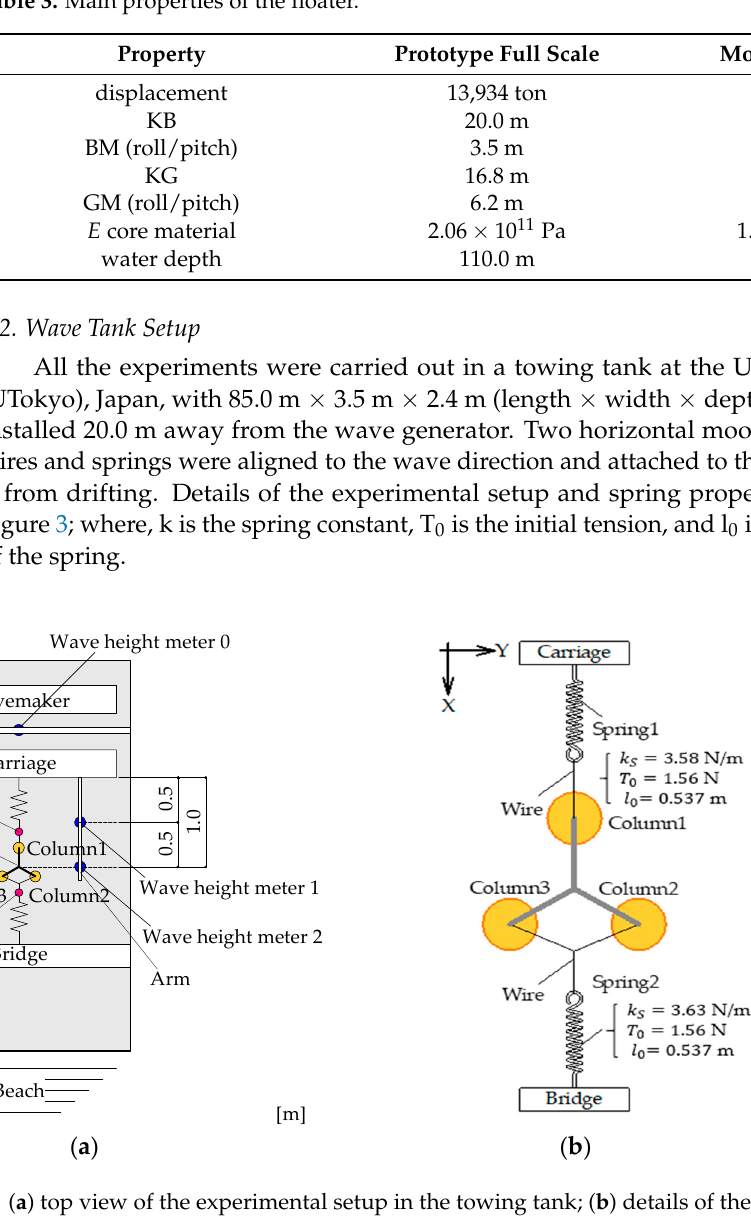
Figure 4. Location of the strain gauges on the experimental model. 2.3. Environmental Conditions Experiments under regular waves were conducted under three different wave heights (18 mm, 36 mm, and 72 mm) and wave periods from 0.7 to 4.1 s. In higher wave cases, wave periods around natural periods of heave and pitch were mainly measured to discuss the effect of wave heights on the viscous damping.